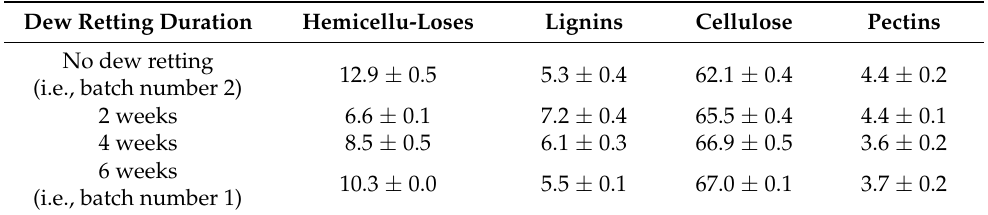
Table 4. Chemical composition of manually extracted fibres as a function of the dew retting duration (from 0 to 6 weeks) (% of dry